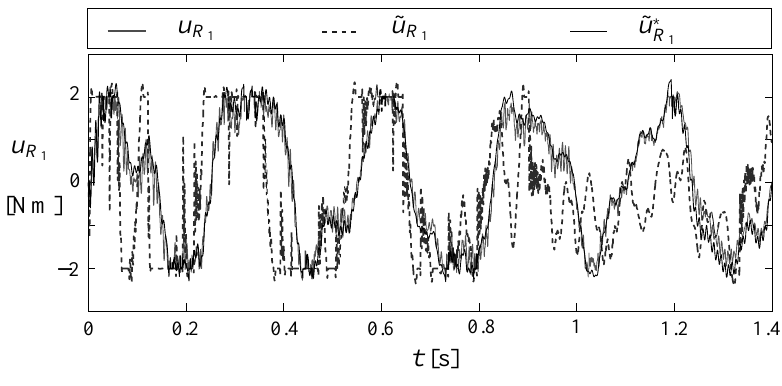
Fig. 10. Approximation of the friction moment u R 1